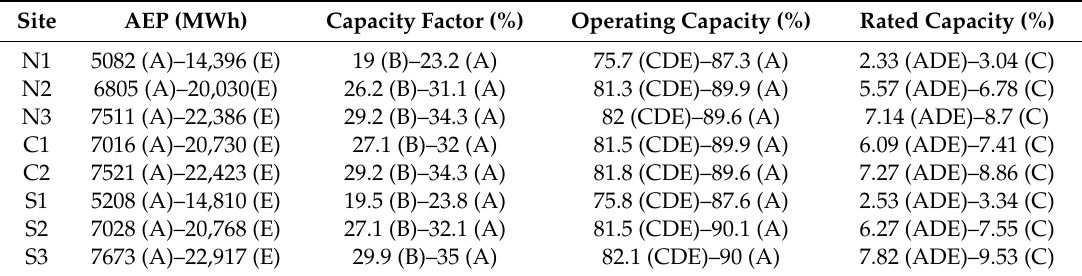
Table 4. Turbines performances ( U 100) evaluated for the 20-year time interval of 2000–2019. Only the minimum and maximum values are indicated for each turbine (A, B, C, D or